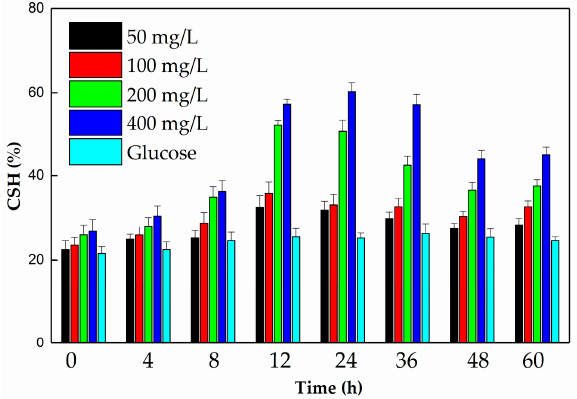
Figure 10. The cell surface hydrophobicity (CSH) of strain YC-YT1 during growth on glucose and different DEHP concentrations. The concentration of glucose was 5 g/L. The error bars indicate the standard deviation of the means ( n = 3).